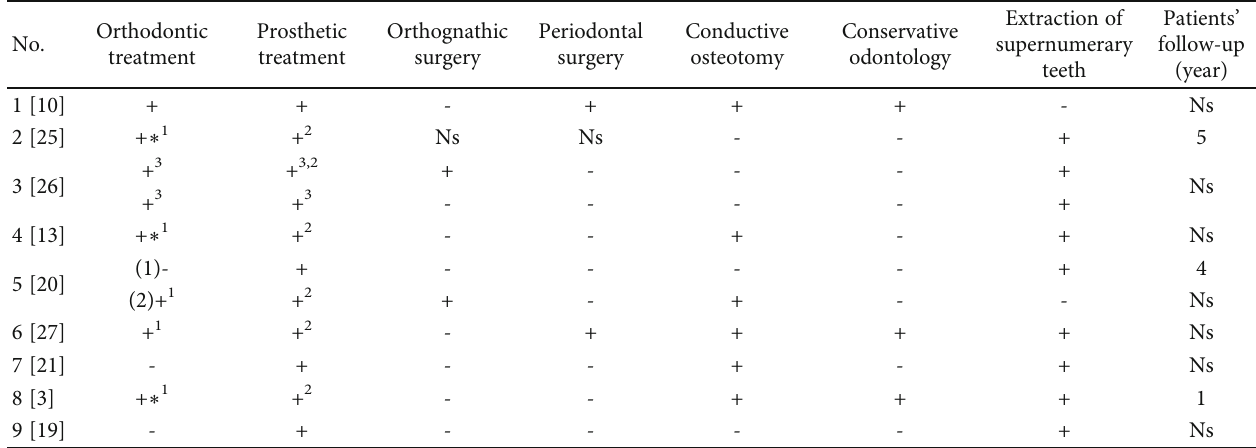
Table 3: Dental therapies of the patients included in the systematic review.